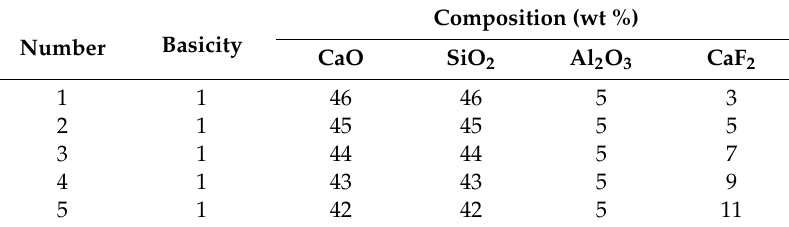
Table 2. Compositions of slags at 1673 K.